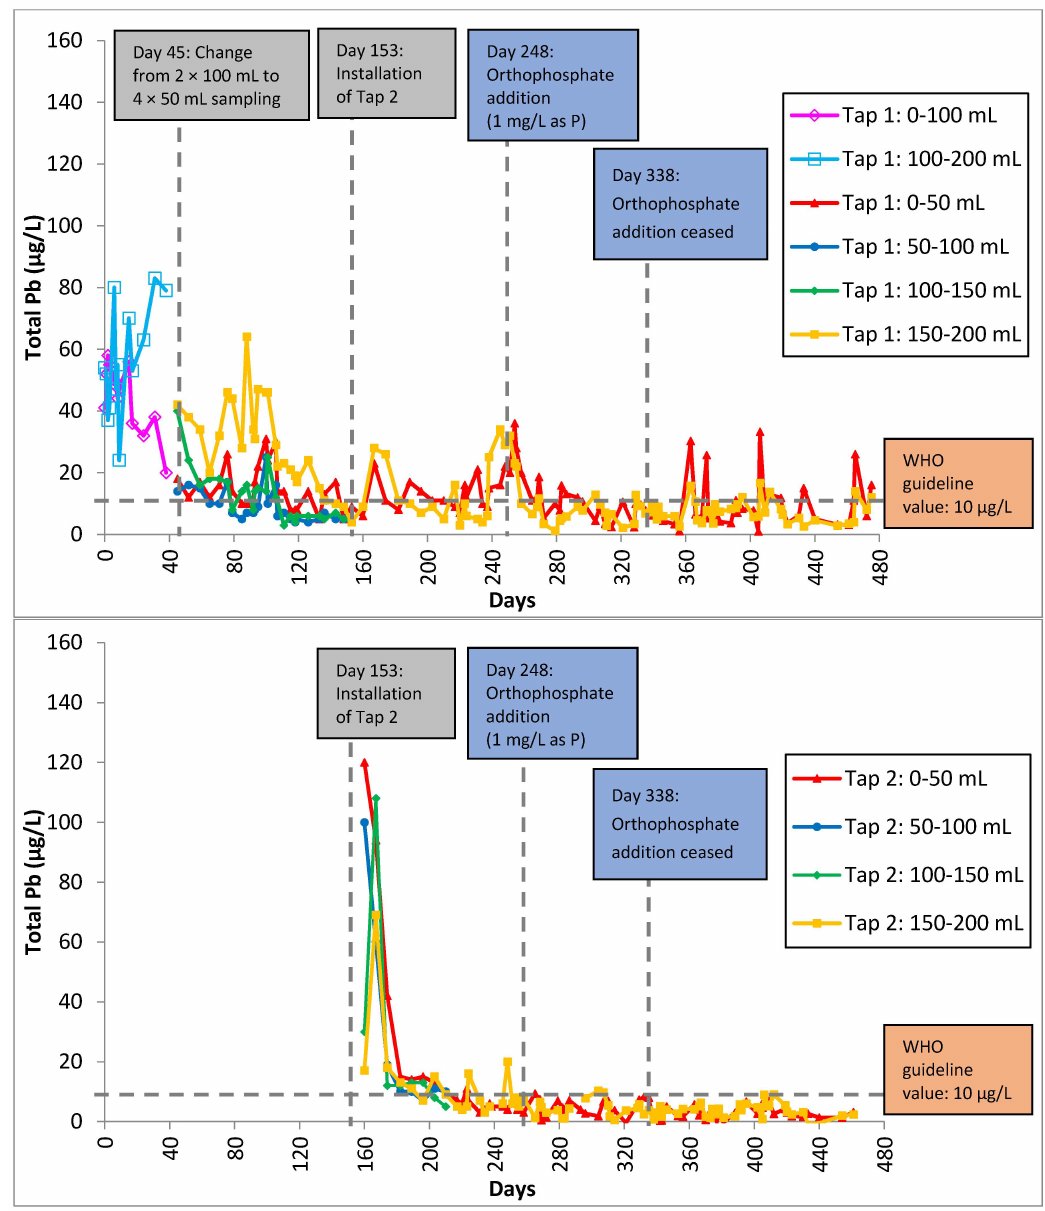
Figure 3. Total lead in Tap 1 ( top ) and Tap 2 ( bottom ) samples as a function of time for 475 days. A second tap was installed on Day 153 and orthophosphate was introduced on Day 248 and discontinued on Day